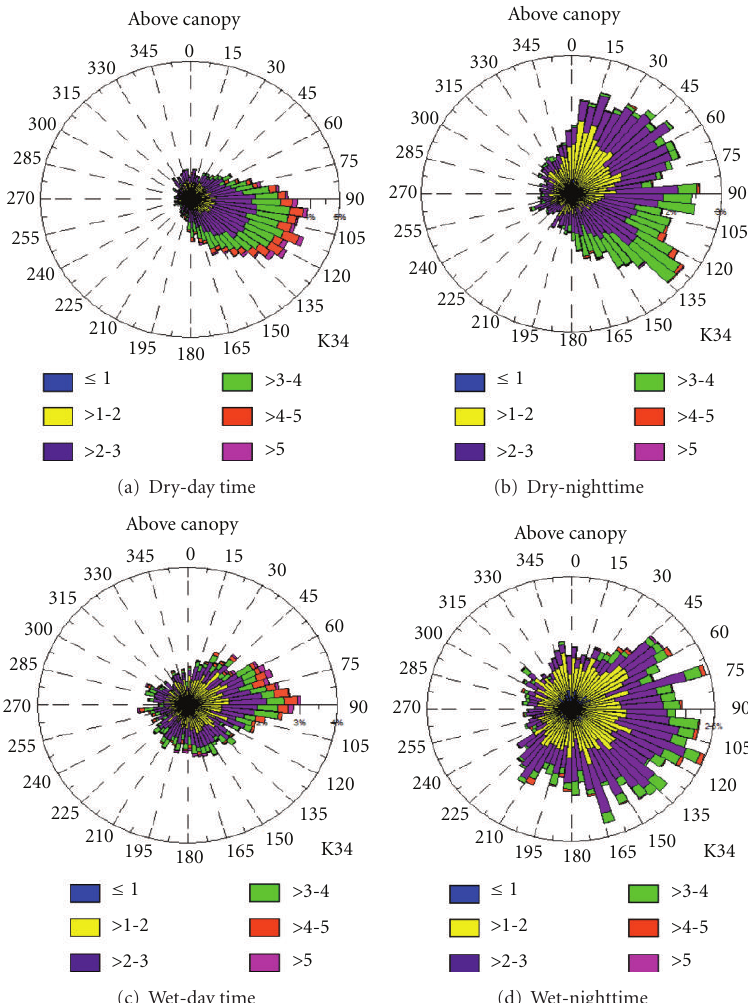
Figure 10: Frequency distribution of the wind speed and direction. For dry ((a), (b)) and wet ((c), (d)) periods from the year 2006 during day ((a), (c)) and nighttime ((b), (d)), on the plateau K34 tower.